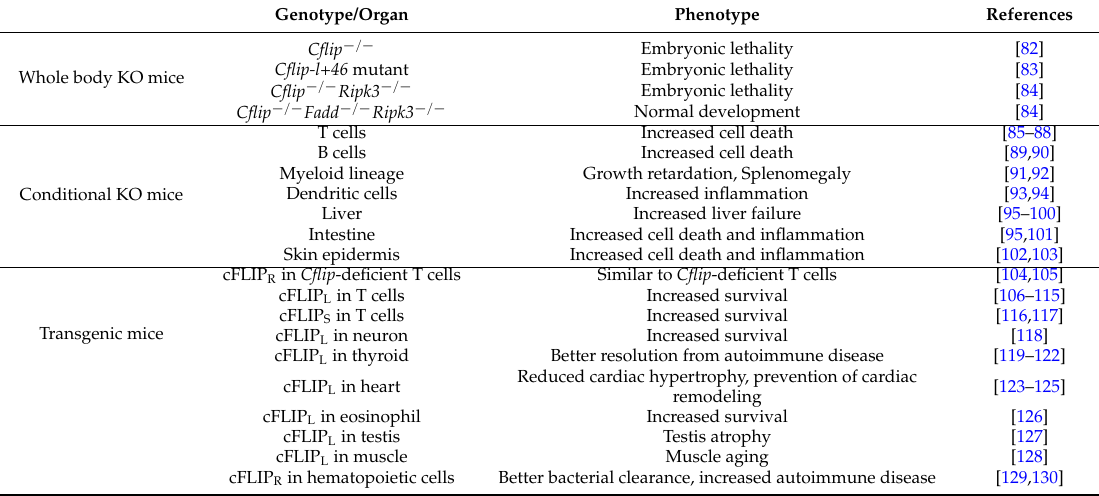
Table 2. Phenotypes of cFLIP gene-manipulated